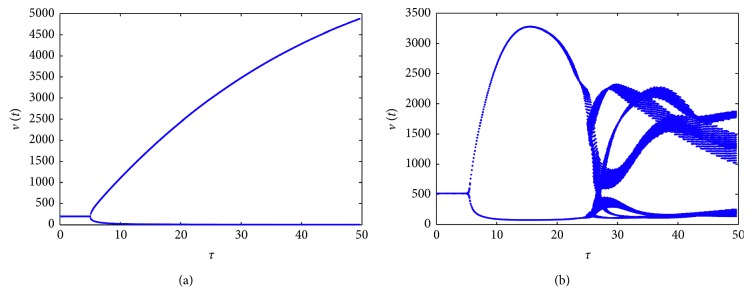
Bifurcation diagrams for model (1) with saturation incidence rate. (a) s=10, β
1=0.002, β
2=0.003, a=1, and b=1. (b) s=20, β
1=0.02, β
2=0.03, a=0.1, and b=0.4. Other parameters are the same.